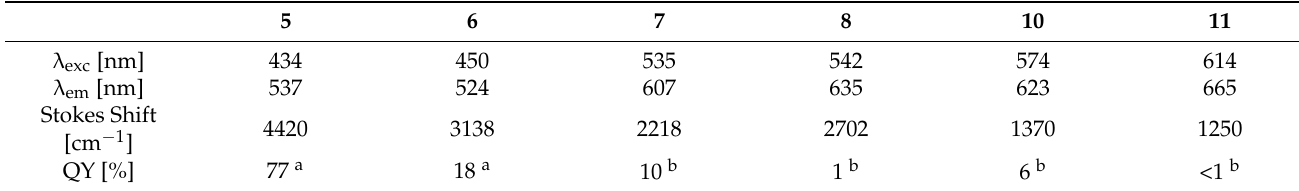
Figure 2. Excitation (solid line) and emission (dotted line) spectra of compounds 5 – 8 , 10 – 11 in CHCl 3 solution ( 5 – 7 , 10 – 11 ) and CH 2 Cl 2 solution ( 8 ). Table 2. Photoluminescence data of compounds 5 – 8 , 10 , 11